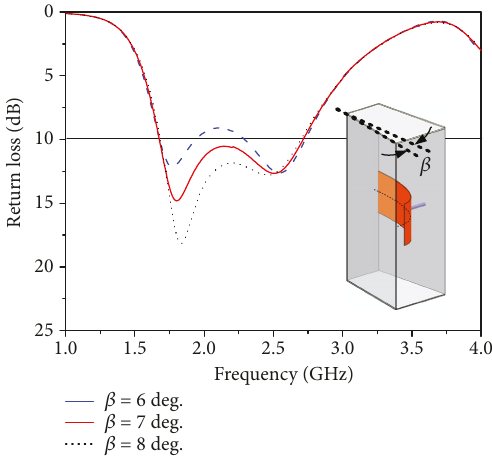
Figure 5: E ff ect of the fl ared angle β on return loss of the wideband HP quasi-omnidirectional antenna.